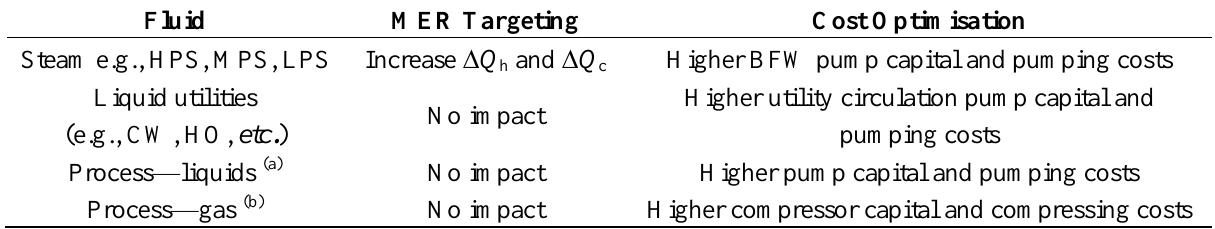
Table 1. Impact of pressure drop on